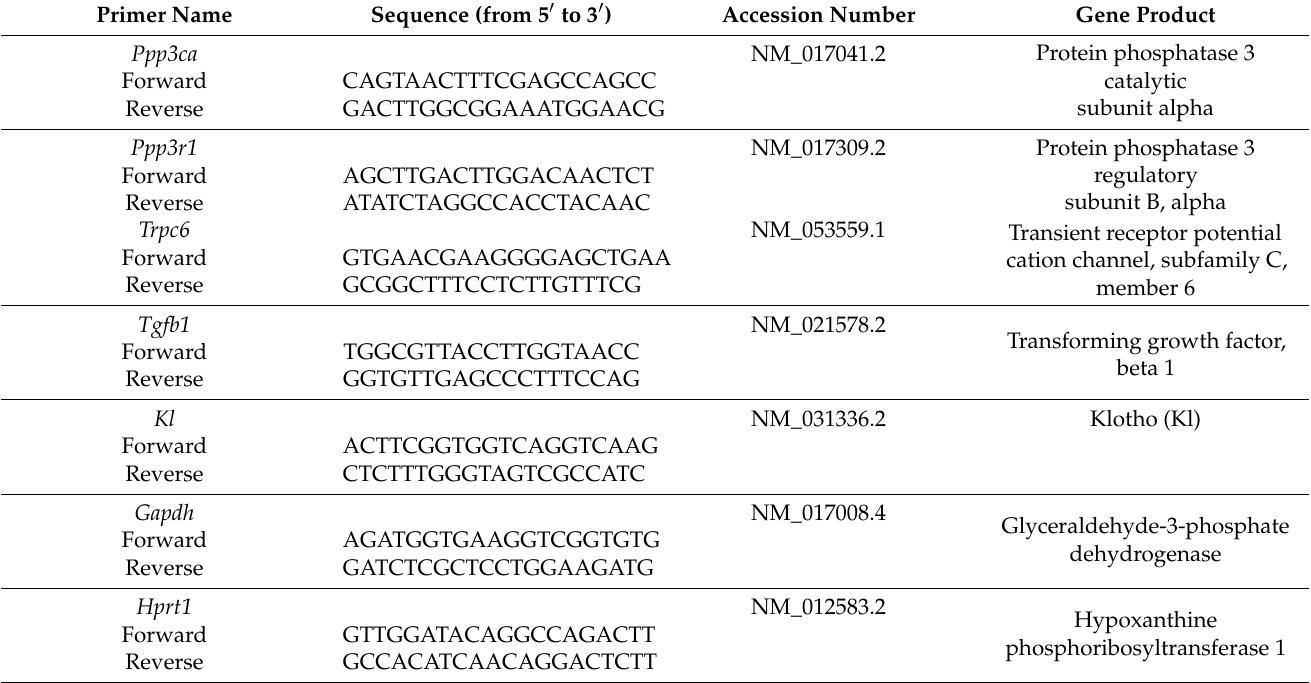
Table 3. Primer sequence for